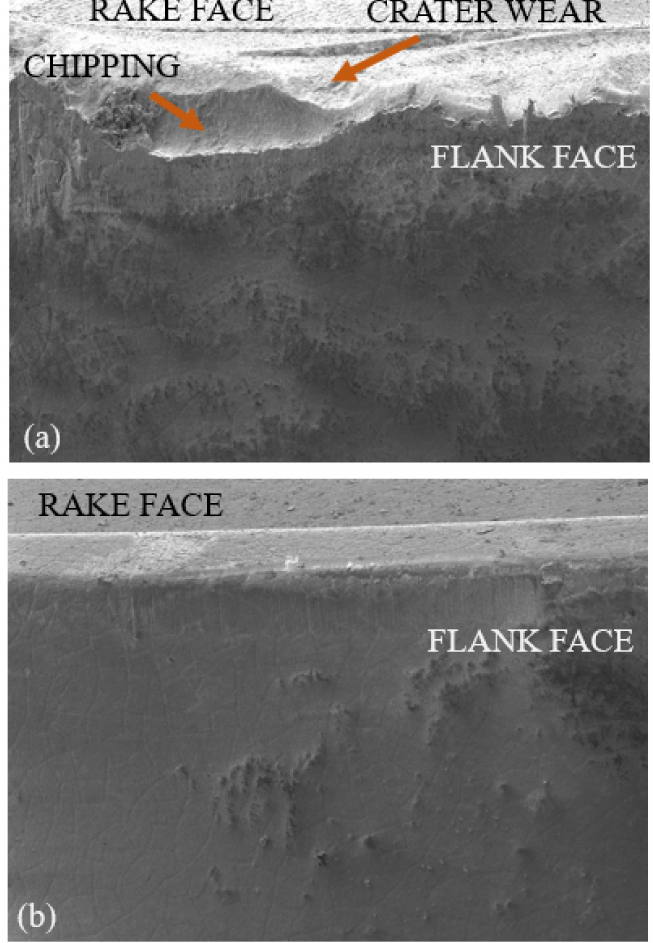
Figure 5. Flank faces of the worn cutting inserts ( a ) Fixed tool; ( b ) SPRT